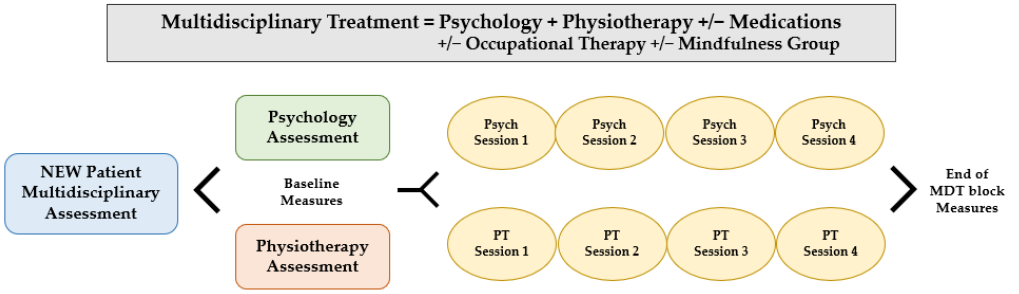
Figure 1. Patient flow from new intake to completion of MDT block. Psych: psychology, PT: physiotherapy, MDT: multidisciplinary.